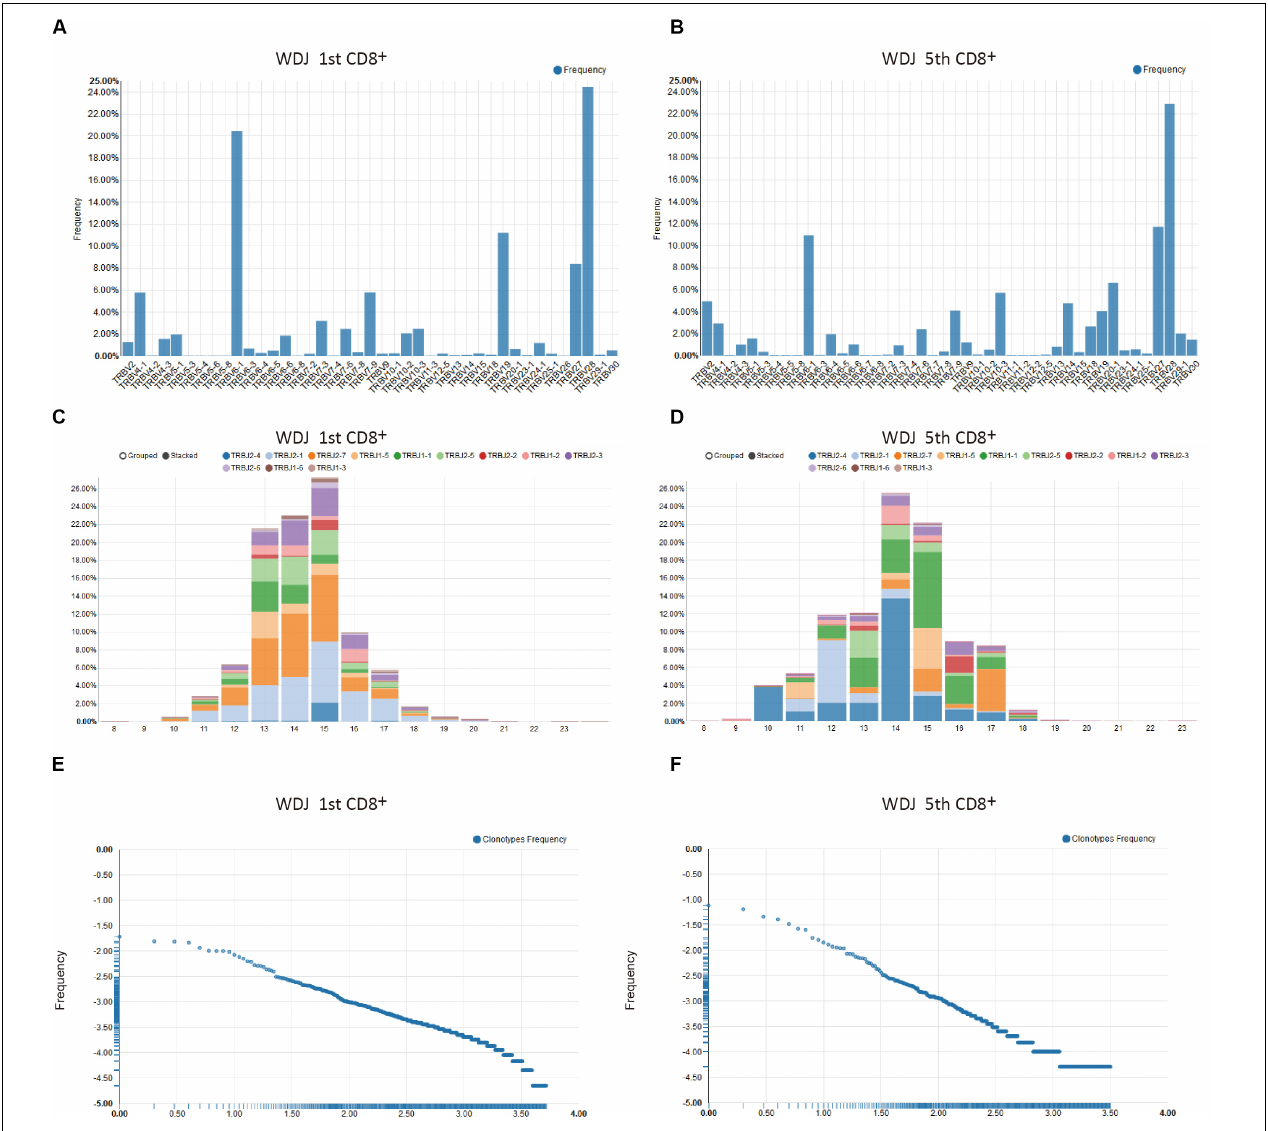
FIGURE 2 | Examples of single sample analysis in VisTCR. The two samples are CD8 + repertoires and obtained at time point 1 and 5 from a representative patient are shown (patient WDJ). (A,B) TRBV segment usage. (C,D) The CDR3 length distribution with TRBJ segment usage. (E,F) Clonotype Frequency plots.